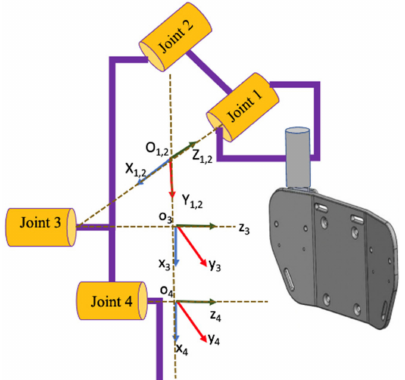
Figure 1. Schematic of wheelchair upper-limb exoskeleton robotic